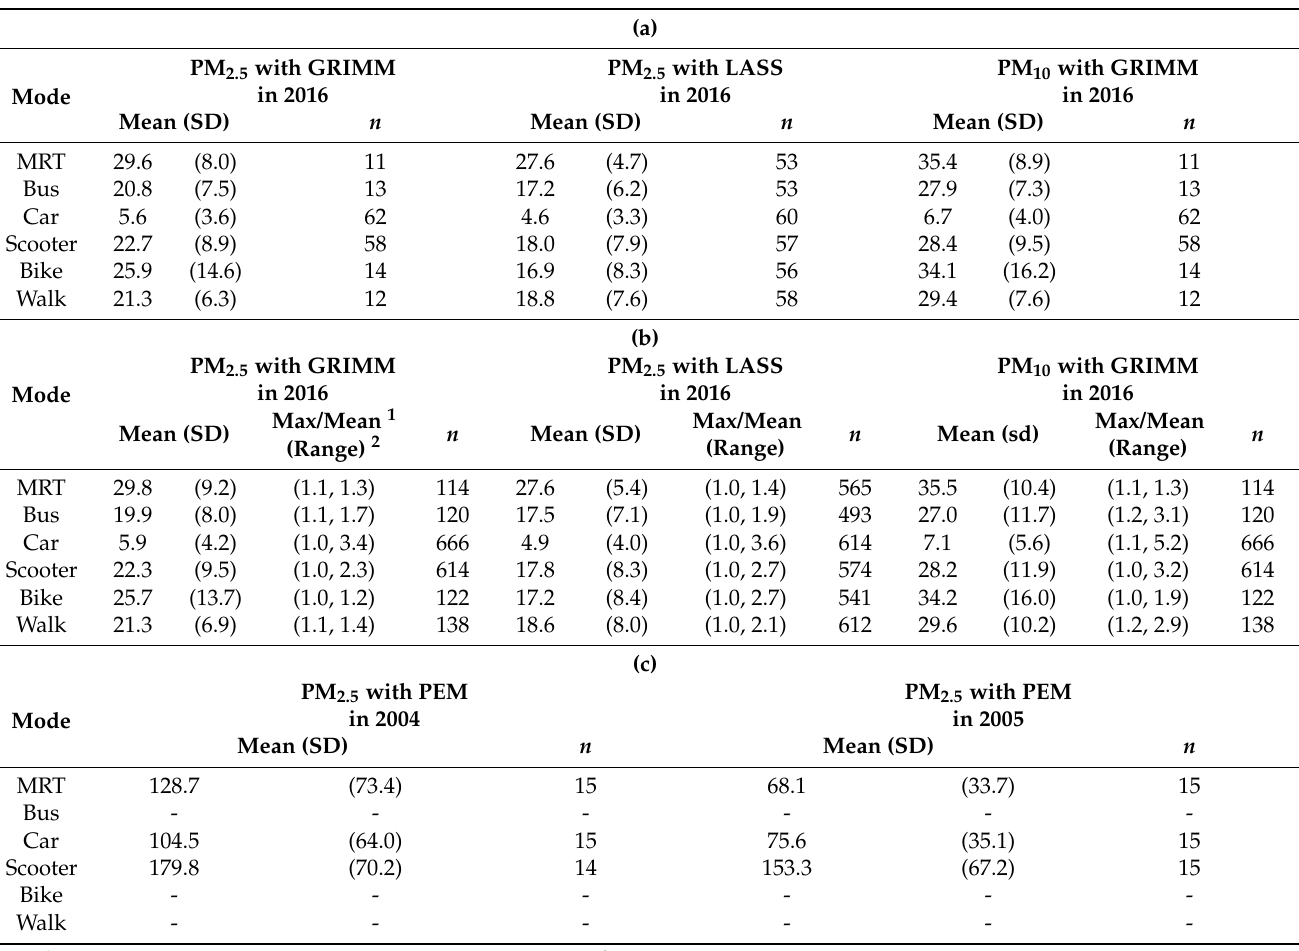
Table 1. PM exposure levels ( µ g/m 3 ) in different transportation modes. ( a ) Hourly averages of PM with GRIMM and LASS in 2016, ( b ) 5 min averages of PM with GRIMM and LASS in 2016 and ( c ) hourly PM 2.5 with PEM in 2004 and 2005.